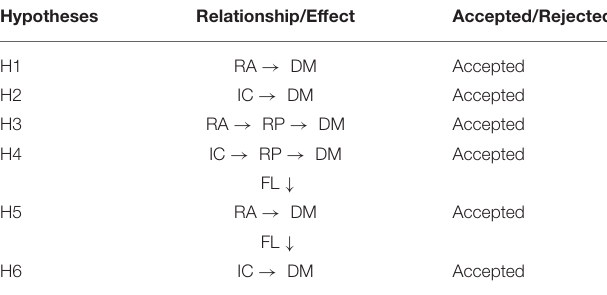
TABLE 9 | Summary of hypotheses.